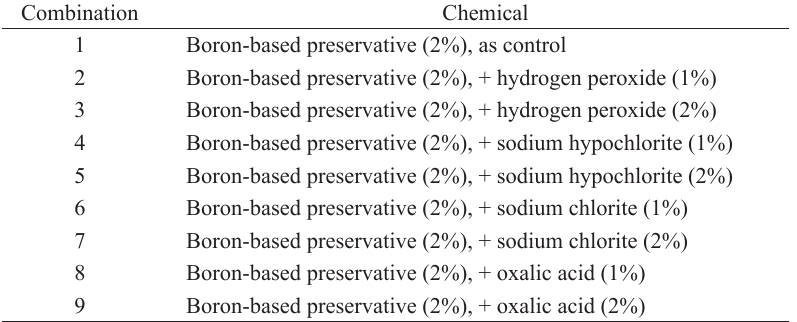
Combination of chemical treatment applied to H. brasiliensis